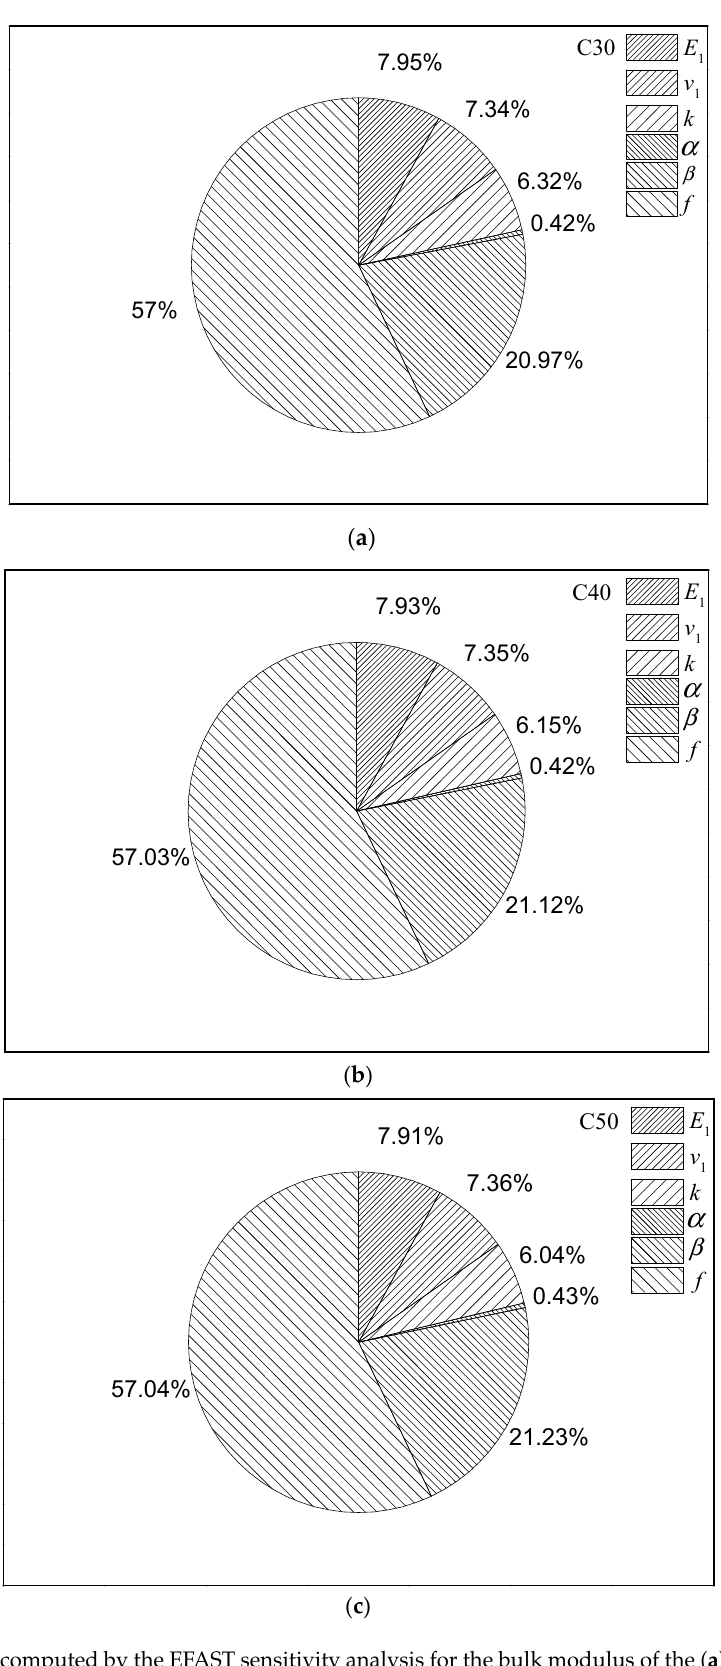
Figure 8. FSIs computed by the EFAST sensitivity analysis for the bulk modulus of the ( a ) C30 concrete, ( b ) the C40 concrete, and ( c ) the C50 concrete.